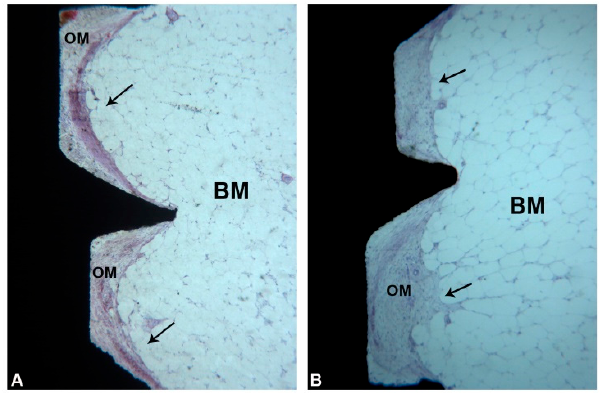
Figure 9. ( A , B ) Marrow portion. A layer of osteogenic matrix (OM) was observed close to the implant surface. This OM was clearly delimited from the bone marrow by a dense band ( black arrows ). (Acid fuchsin-Toluidine blue 18X).